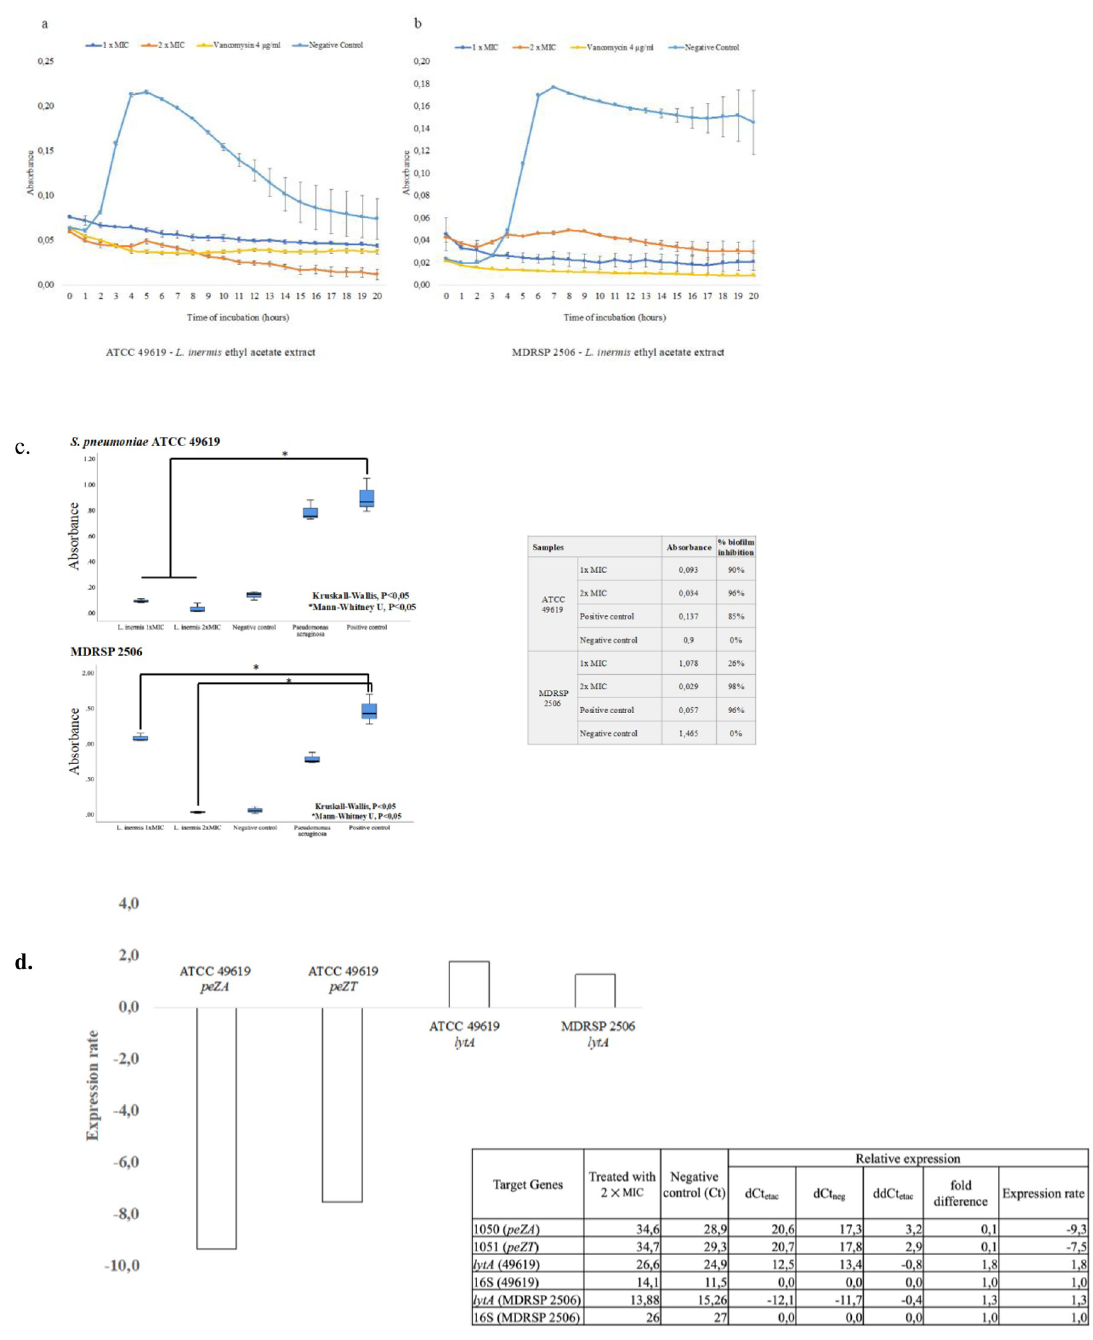
Fig 4. Mechanism of action of Lawsonia inermis ethyl acetate extract on Streptococcus pneumoniae . a) Bacterial lysis curves of S . pneumoniae ATCC 49619, b) Bacterial lysis curves of MDRSP 2506, c) antibiofilm activity, d) Expression rate of peZA , peZT , and lytA . Bacterial lysis measurement was performed by measuring absorbance of 595 nm each 1 hour of 20 hours of incubation. Lawsonia inermis final concentrations at 1 × MIC, 2 × MIC and 10 × MIC were used for incubation, vancomycin at final concentration 4 μ g/ml was used as growth control under antibiotic exposure while untreated cells were used as negative control. Antibiofilm activity was measured by using 1% crystal violet for detection. Initial enrichment was done in BHI supplemented with rabbit serum incubated for 5 hours. Lysed-sheep blood was used for inducing biofilm formation performed in 96-well plate flat bottom. PBS 1 × was used for plate washing and 0,5% crystal violet was used to detect biofilm formed in each well. Lawsonia inermis final concentrations at 1 × MIC, and 2 × MIC were used for inhibition testing, mouthwash at final concentration 1:10 was used as inhibition control while untreated cells were used as negative control. Prior to RNA extraction, the pathogen (1 McFarland) was incubated with 2 × MIC of L . inermis ethyl acetate extract for 1 hours. RNA concentration was measured by RNA Qubit HS kit. Expression rate was measured by two-steps qRT-PCR. https://doi.org/10.1371/journal.pone.0274174.g004 PLOS ONE | https://doi.org/10.1371/journal.pone.0274174 September 13,